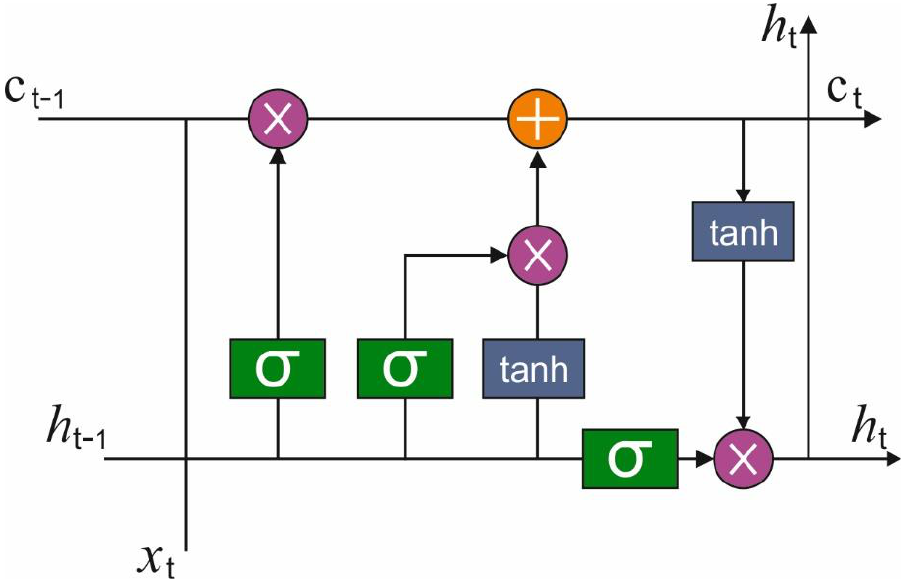
Figure 2. Architecture of LSTM.